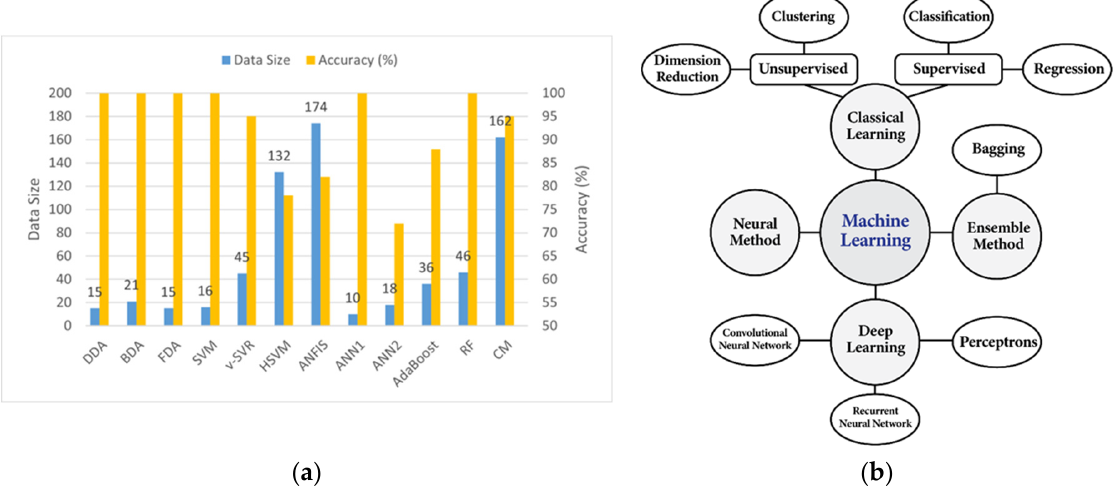
Figure 12. ( a ) Rockburst prediction accuracy from machine learning algorithms (modified from ref. [176]); ( b ) Machine learning approaches for rockburst prediction (Modified after ref. [11]).